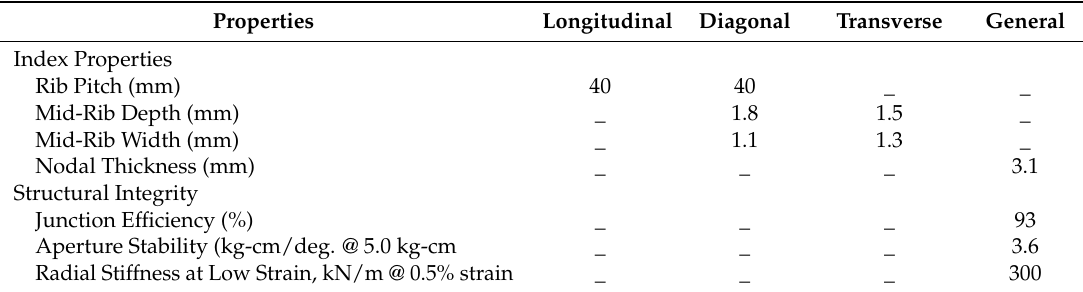
Figure 1. Geogrid specimen with strain gages attached on ribs at various location. Table 2. Index and mechanical properties of geogrids [24].